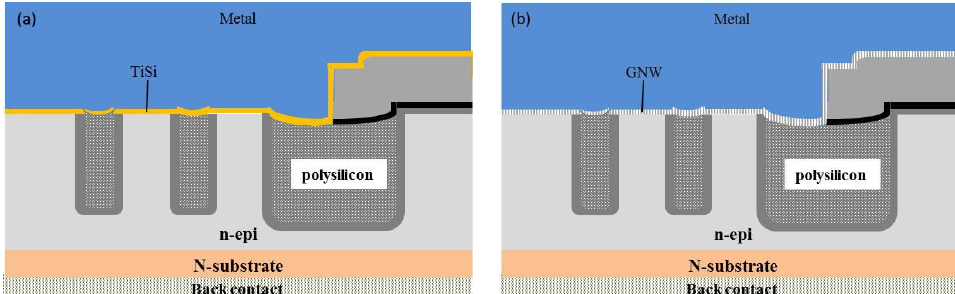
Figure 1. Cross-sectional diagram of trench Schottky structure with ( a ) TiSi 2 and ( b ) GNW as Schottky barrier layer.